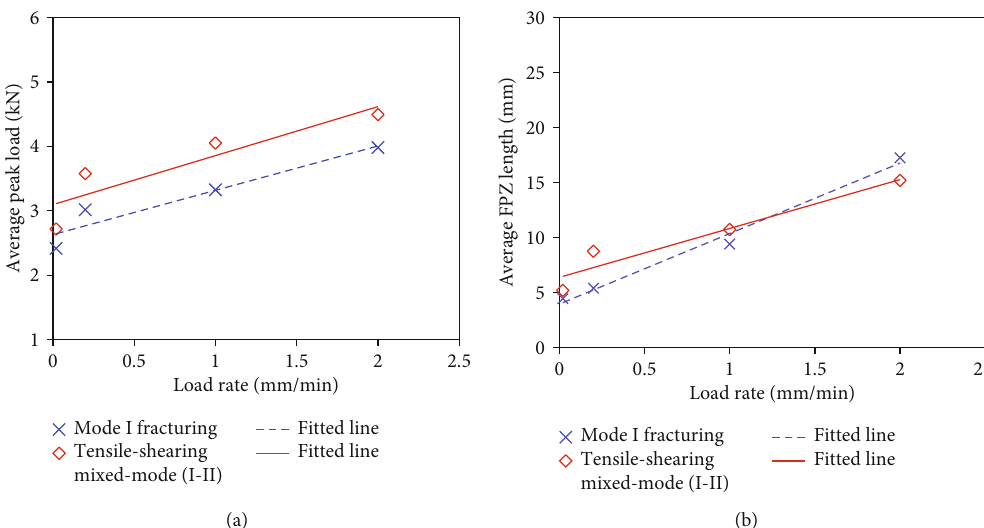
Figure 3: The evolution law of FPZ length and peak load with loading rates increasing: (a) peak load vs. loading rates; (b) FPZ length vs. loading